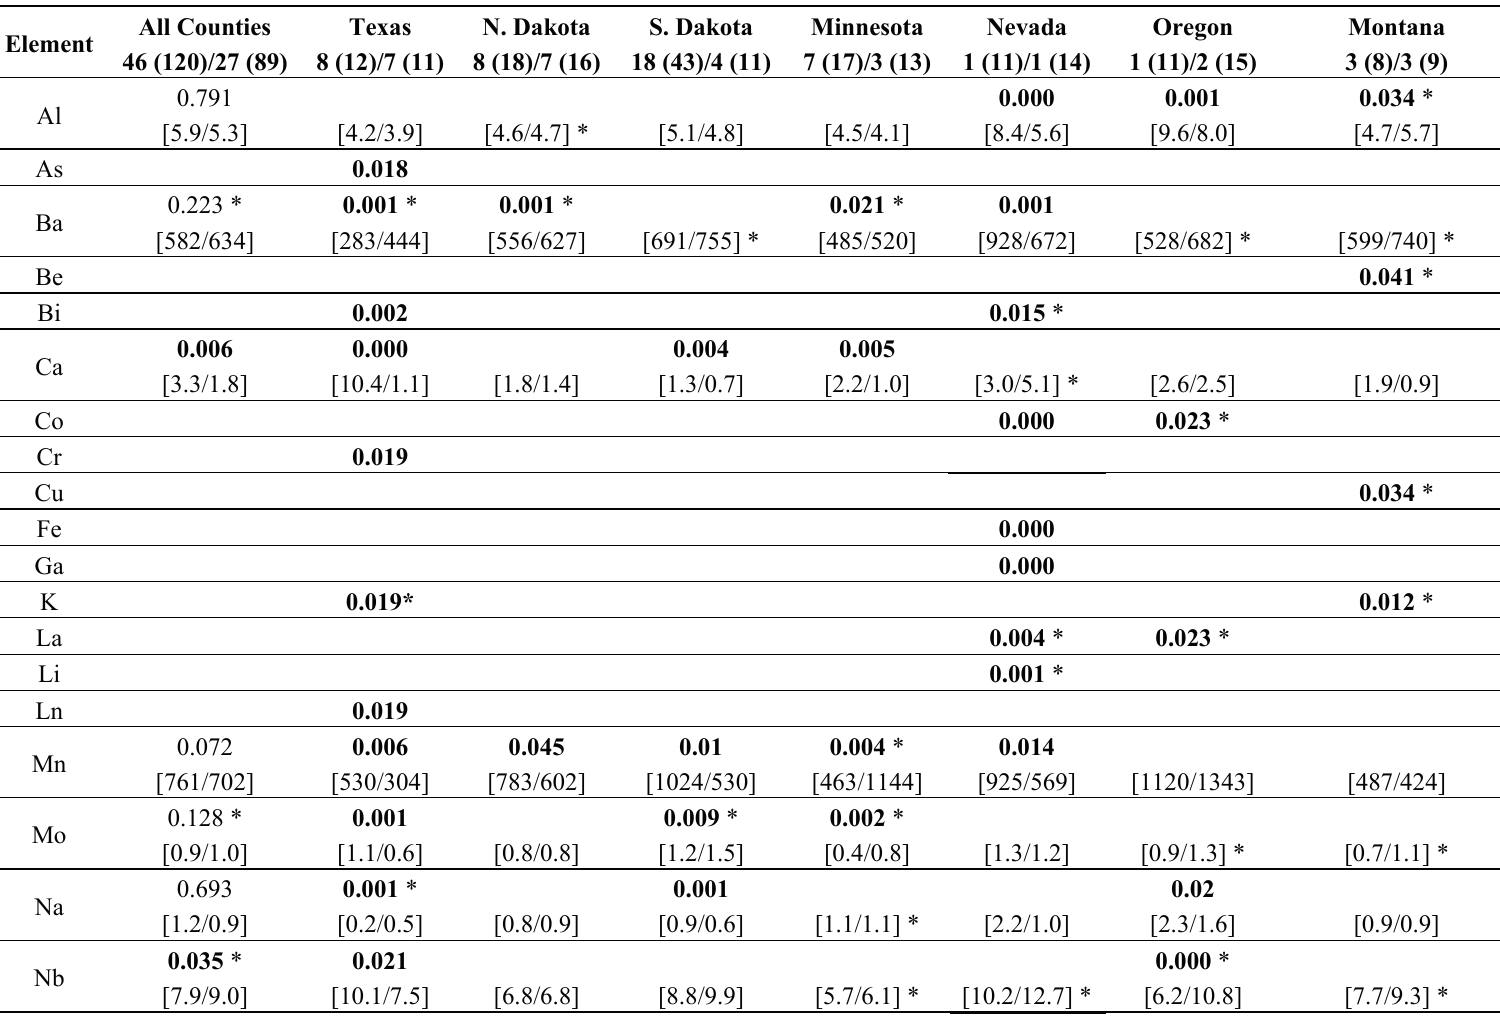
Table 2. The significance (Mann–Whitney U test p- values; in bold where <0.05) of elemental concentrations (averages in brackets [#/#] where there was an overall or greater than two state significant p -values) in counties reporting outbreaks or cases of anthrax in livestock and wildlife versus counties that have not reported outbreaks or cases of anthrax since the year